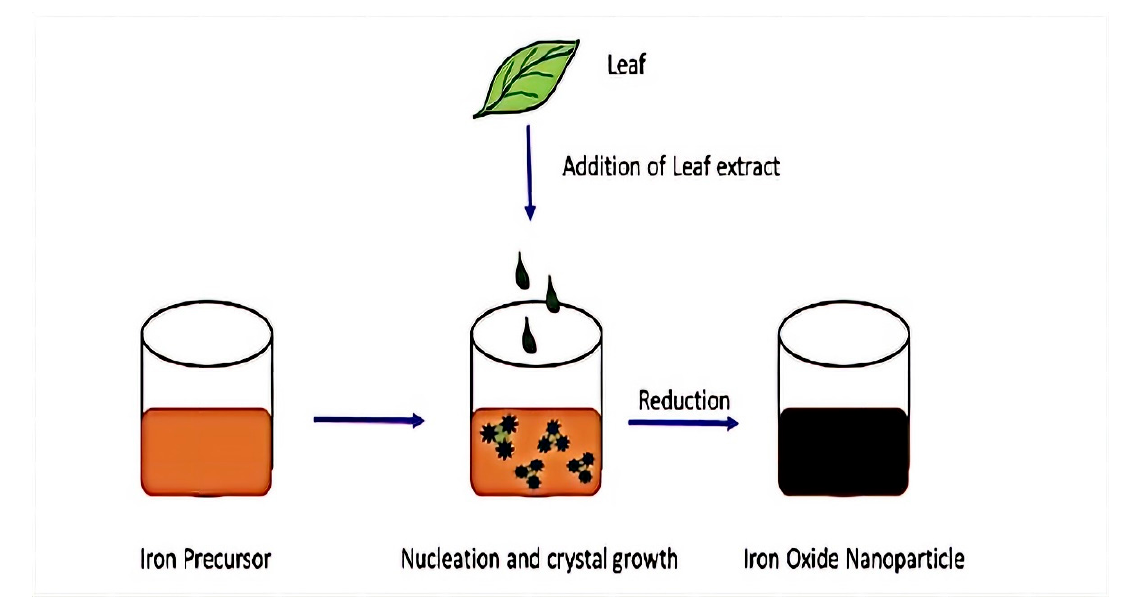
Figure 7. Magnetite nanoparticle synthesis using plant extracts (adapted from [70] with permission from Elsevier).